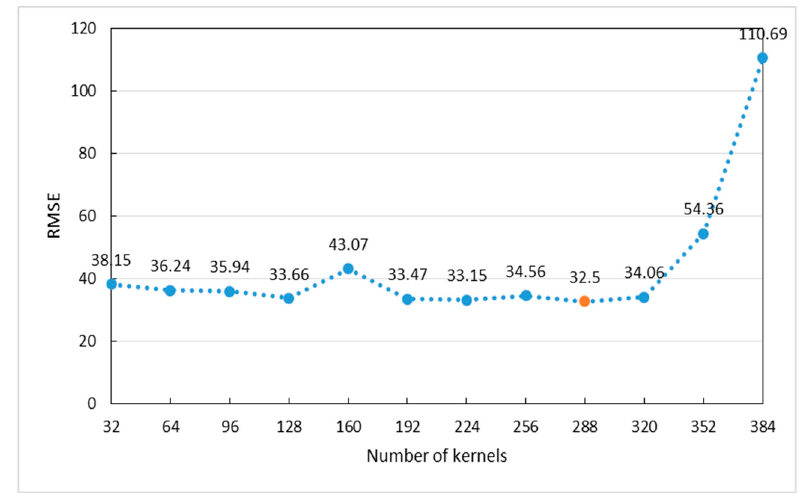
Figure 13. Experimental results with different numbers of kernels.